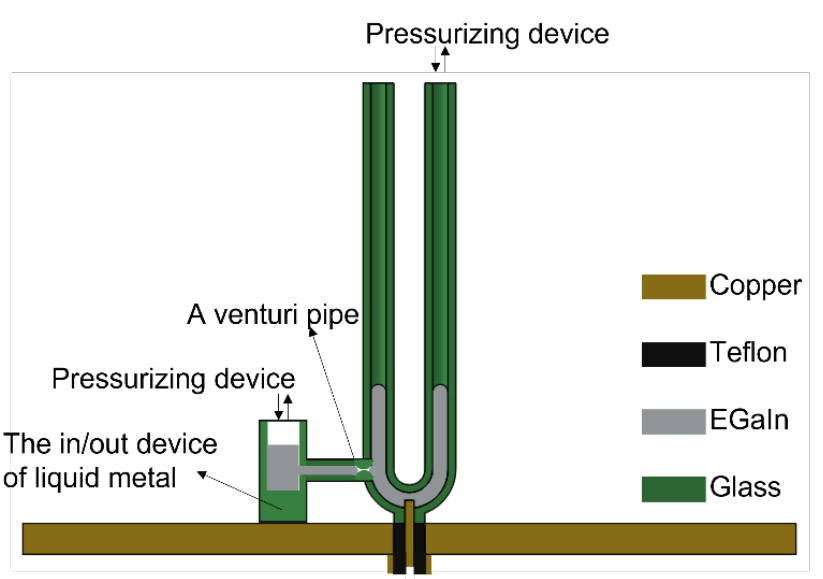
Figure 10. A more optimized structure of this antenna.